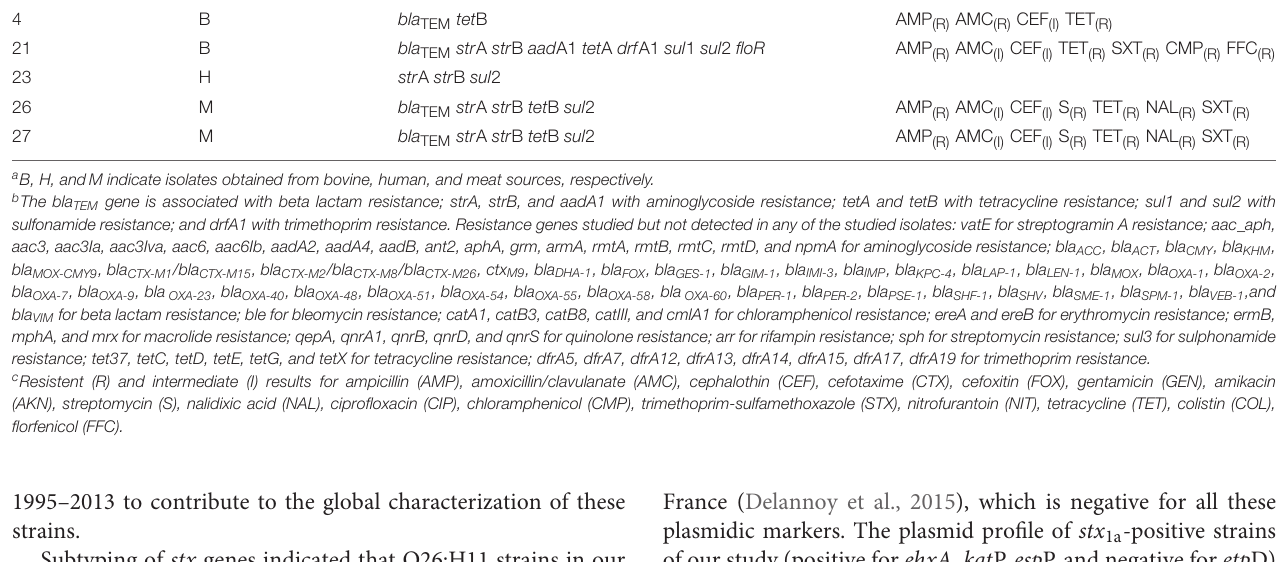
TABLE 2 | Antibiotic resistance profiles present in O26:H11 STEC isolates.